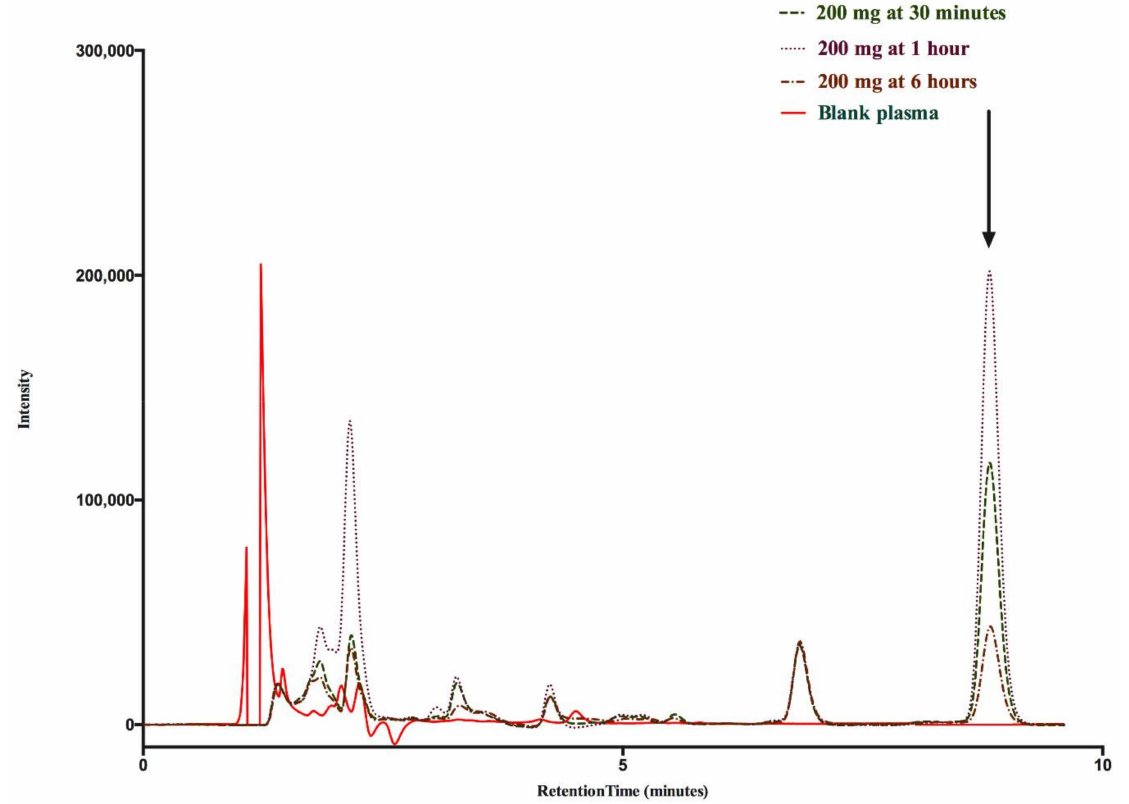
Figure 1. Chromatographs showing SA peaks at 30 min, 1 h (T max ) and 6 h after oral administration of 200 mg/kg SS in sheep; while a drug-free/blank plasma of a sheep represented by orange line has no peak at the retention time of salicylic acid. Arrow represents salicylic acid